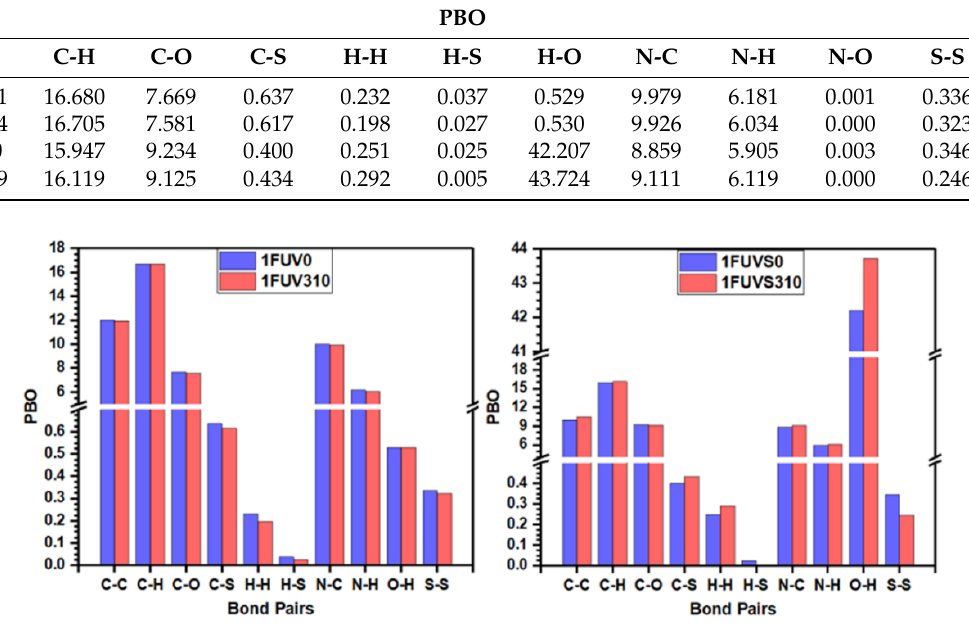
Figure 4. Comparison of PBO values for each bonded pair in dry and solvated 1FUV at 0 K and 310 K.